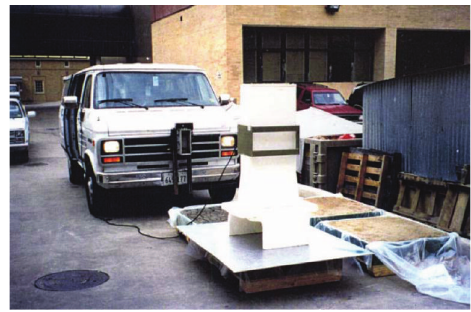
Figure 3: Ground penetrating radar and box test sample.